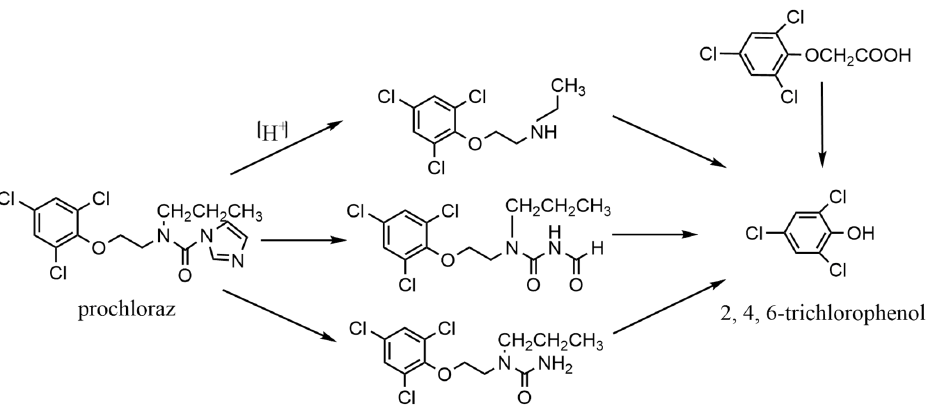
Figure 1. Degradation pathways of prochloraz.